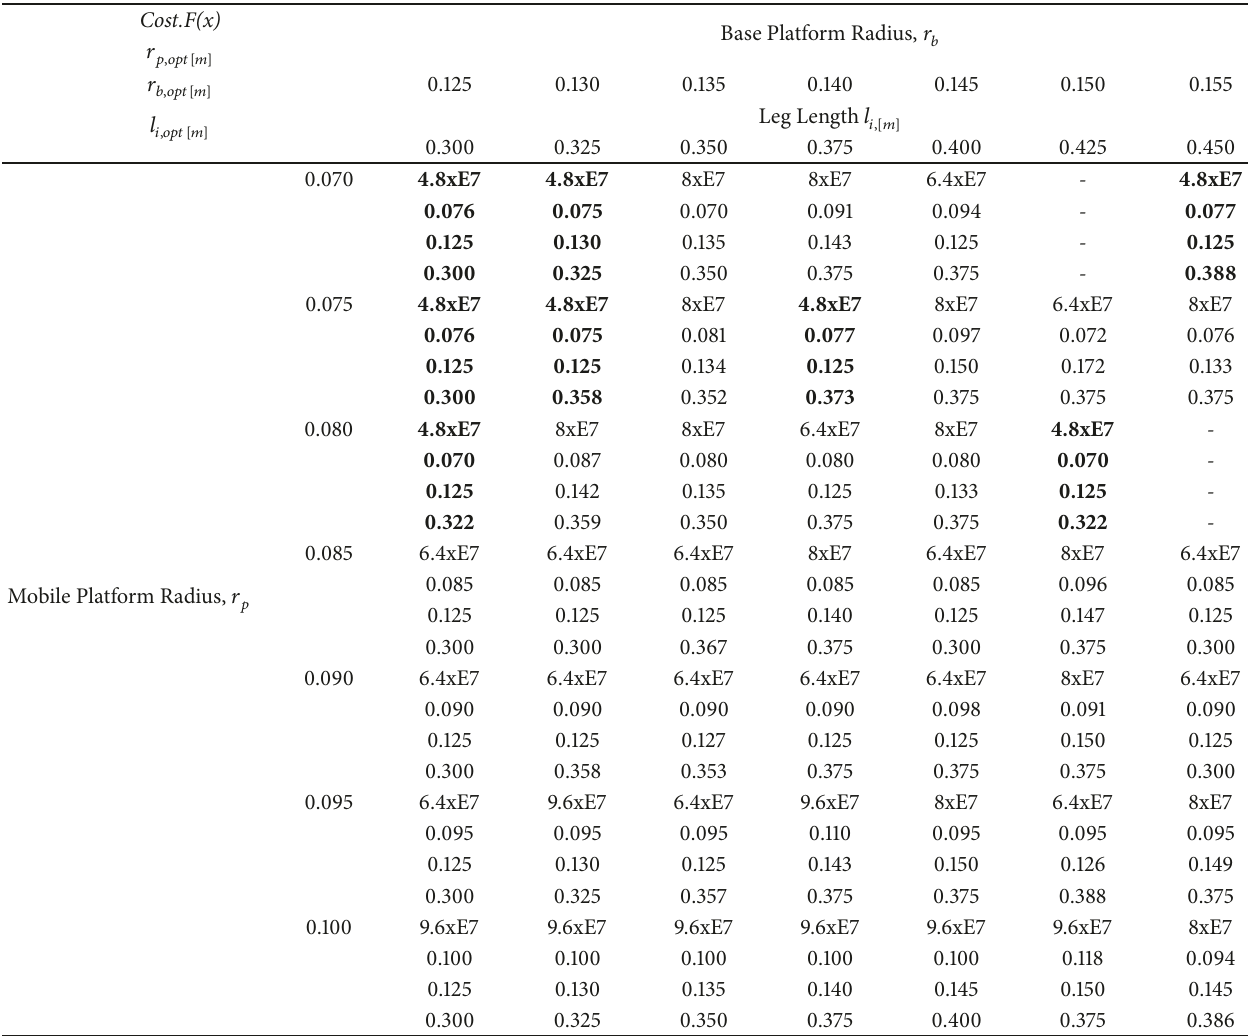
Table 4: Optimizing mobile platform diameters, 𝑟 𝑝 , and optimum leg length, 𝑙 𝑖 . Cost.F(x)